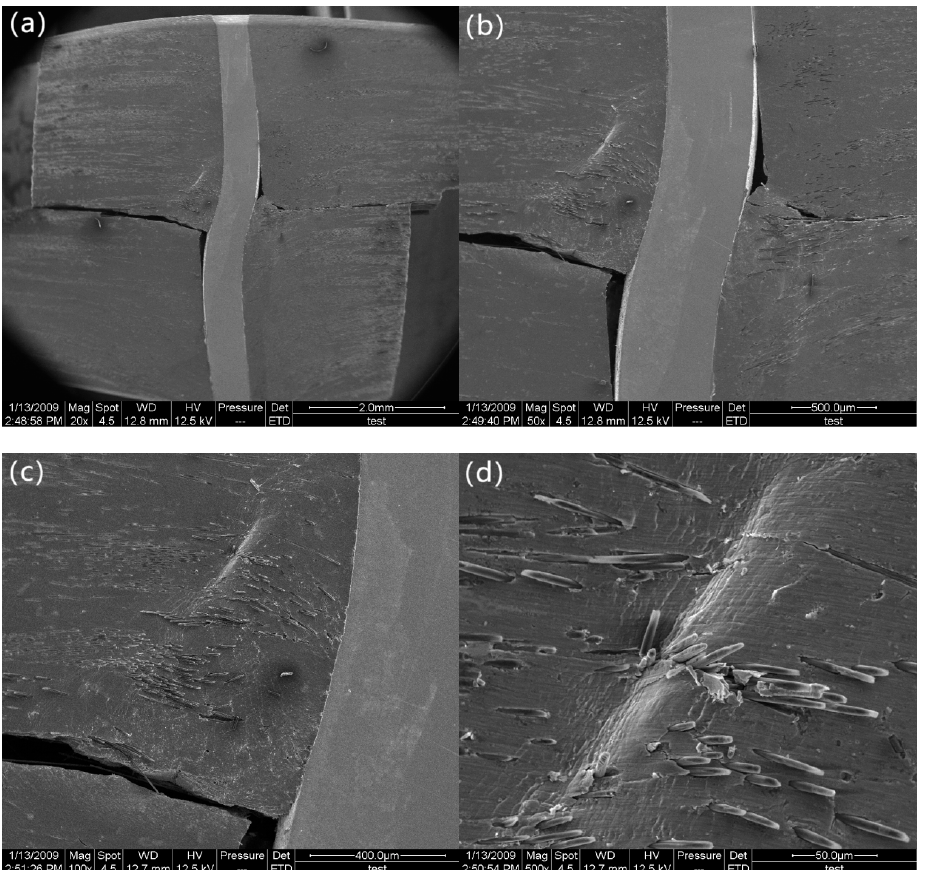
Figure 6. Morphology of the specimen when the matrix is deformed: ( a ) deformed z-pin at low magnification, ( b ) deformed z-pin at high magnification, ( c ) deformed matrix at low magnification, and ( d ) deformed matrix at high